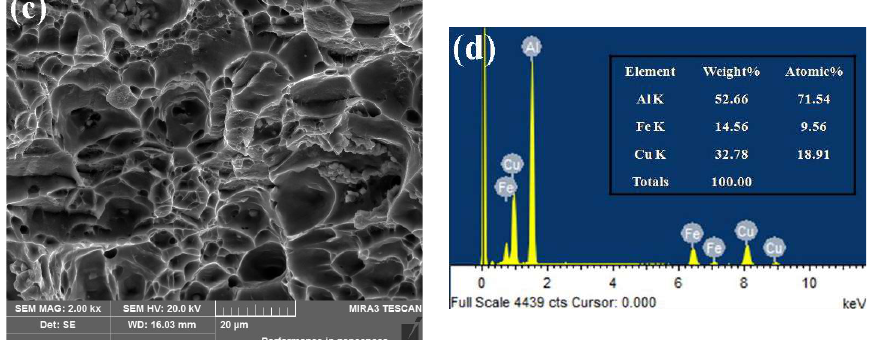
Figure 8. SEM images for fracture morphologies of AA7050 during creep aging tensile tests under 165 °C and different stress levels: ( a ) 300 MPa; ( b ) 325 MPa; ( c ) 350 MPa; and, ( d ) component analysis of second phase particle.